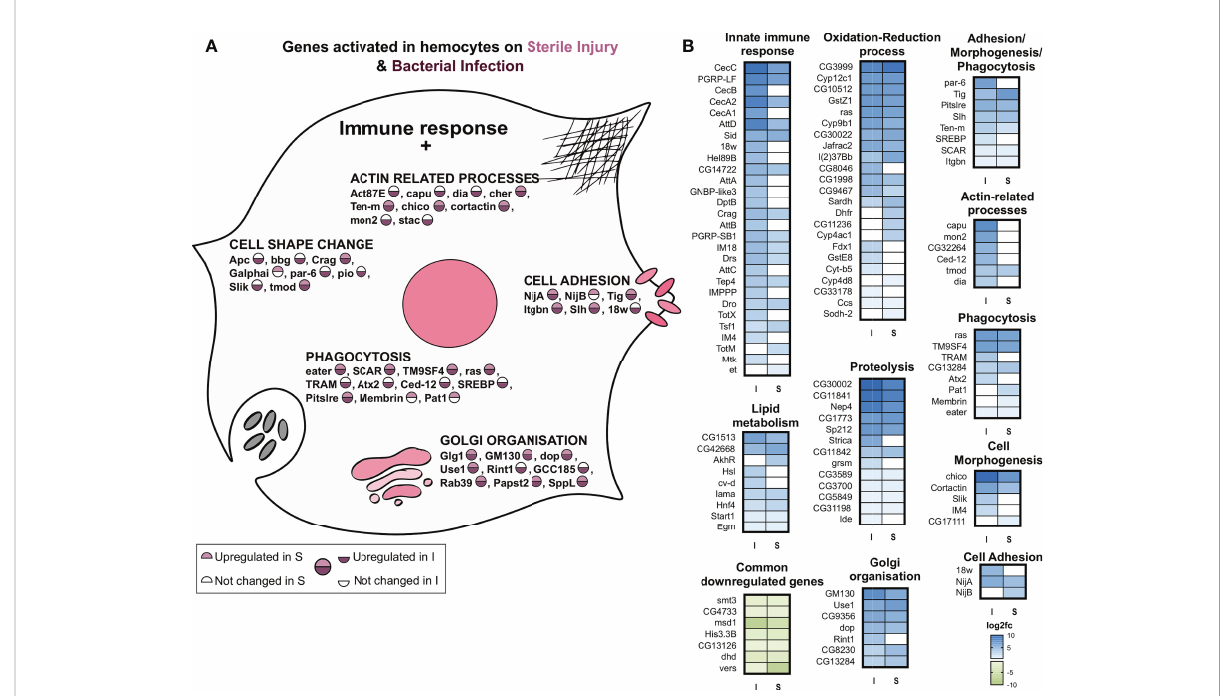
FIGURE 5 GO term analysis of the processes that are regulated in response to infection or sterile injury in adult hemocytes. (A) Summary of the processes activated in addition to the classic antibacterial response in hemocytes to bacterial infection (I) or sterile injury (S). For each process, selected genes are shown with the circle depicting their activation in I and S. As shown in the scale below, the upper half of the circle shows the upregulation in S, where no color means no change in expression while pink shows upregulation. The lower half shows the same information for I, with no color for no expression change and maroon for upregulation. (B) The log 2 fold changes of genes associated with the GO terms of the processes shown A are plotted as heatmaps for bacterial infection (I) and sterile injury (S) hemocytes. The commonly downregulated genes in I and S are also